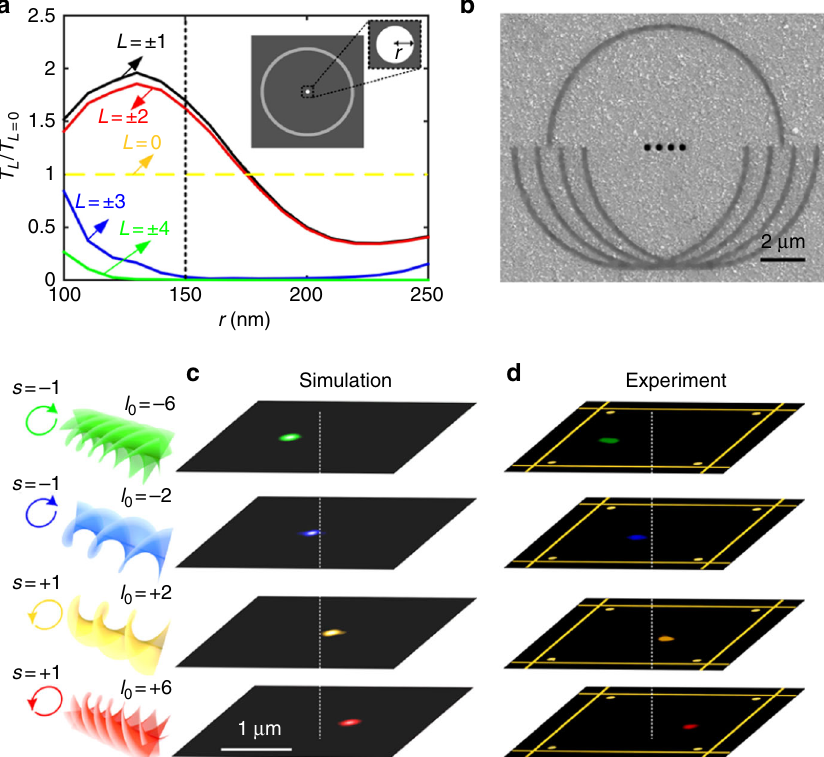
Fig. 4 Characterization of OAM nanometrology in an ultrathin Sb 2 Te 3 thin fi lm. a Optical transmission of different total angular momentum modes L as a function of radius ( r ) of the mode-sorting nanoaperture. The transmittance curves for different angular momentum modes are normalized by the fundamental mode result with L = 0. The inset shows the schematic of the simulated nanostructures which consist of a shallow circular nanogroove and a drilled-through nanoaperture. The black dotted line labels out a mode-sorting nanoaperture waveguide with a radius of r = 150 nm used in the OAM nanometrology device. b SEM image of the fabricated four-states OAM nanometrology device. c , d Simulated ( c ) and experimental ( d ) characterization of the CMOS-integratable OAM nanometrology by inspecting the far- fi eld transmittance patterns of the four AM modes with a spatially distinguishable shift